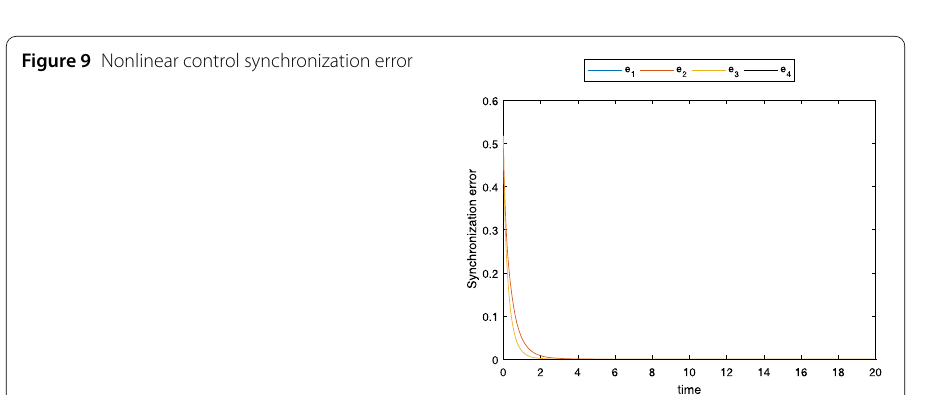
Figure 8 Nonlinear control synchronized trajectories